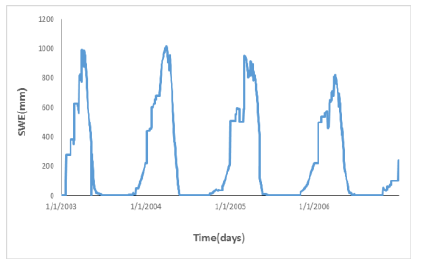
Figure 4.4. Snow Cover Comparison